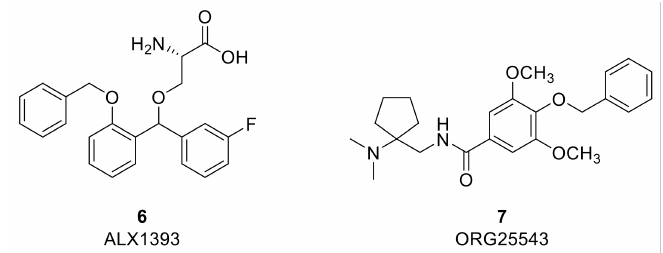
Figure 3. GlyT2 inhibitors ALX1393 and